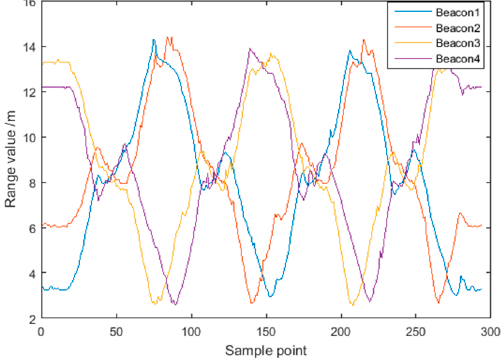
Figure 15. UWB range values for Route 2.